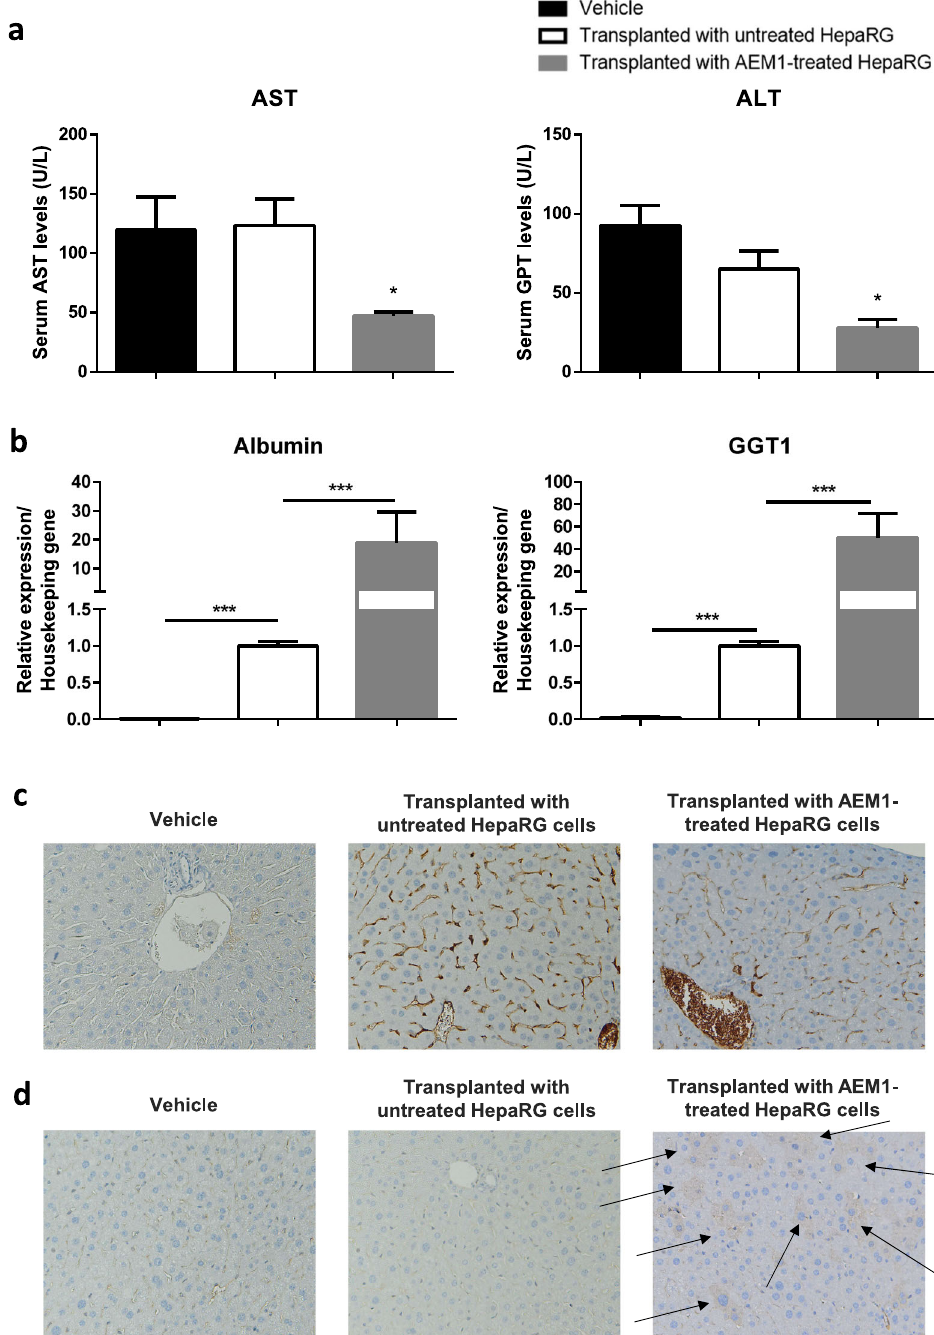
Fig. 5 Transplanted AEM1-treated HepaRG cells allow recovery from liver injury. a Serum aspartate (AST) and alanine aminotransferase (ALT) levels from SCID Beige mice treated with Jo2 mAb once weekly for 4 consecutive weeks after transplantation. Data in the graph are represented as mean ± SD of four independent experiments. Statistical differences were assessed by one-way ANOVA and Tukey as post hoc test. * p < 0.05 vs untrasplanted and vs trasplanted with untreated HepaRG. b mRNA expression of human albumin and gamma-glutamyl transpeptidase 1 (GGT1) in the liver of SCID beige mice treated with Jo2 mAb once weekly for 4 consecutive weeks after transplantation. Data in the graph are represented as mean ± SD of four independent experiments. Statistical differences were assessed by one-way ANOVA and Tukey as post hoc test. *** p < 0.001. c Representative images showing immunohistochemical detection of human Cytokeratin 19 in the liver of SCID Beige mice treated with Jo2 mAb once weekly for 4 consecutive weeks after transplantation (magni fi cation ×200). d Representative images showing immunohistochemical detection of human Glypican 3 in the liver of SCID beige mice treated with Jo2 mAb once weekly for 4 consecutive weeks after transplantation (magni fi cation